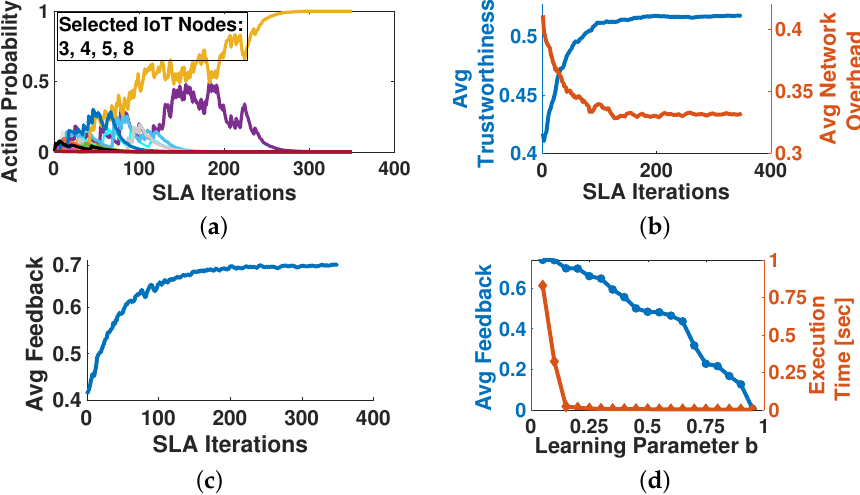
Figure 2. Stochastic Learning Automata operation and performance evaluation. ( a ) Action Proba- bility vs. Iterations, ( b ) Average Trustworthiness & Network Overhead vs. Iterations, ( c ) Average Personalized Feedback vs. Iterations, ( d ) Average Personalized Feedback and Convergence Time vs. b